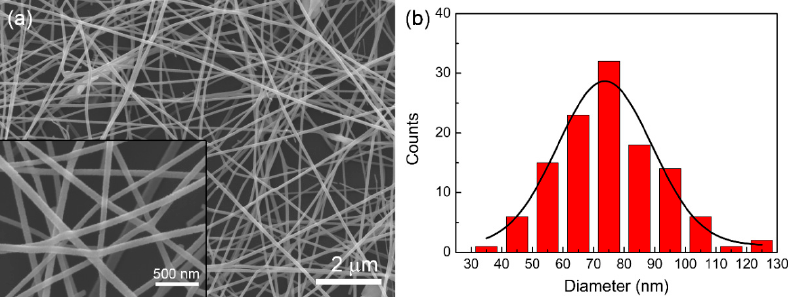
Figure 1. ( a ) The field-emission scanning electron microscopy (FESEM) images of the as-synthesized NaNbO 3 nanofibers (NFs) after being annealed at 700 °C. The inset picture is the magnified image, and ( b ) is the statistical result of the NFs’ diameters.